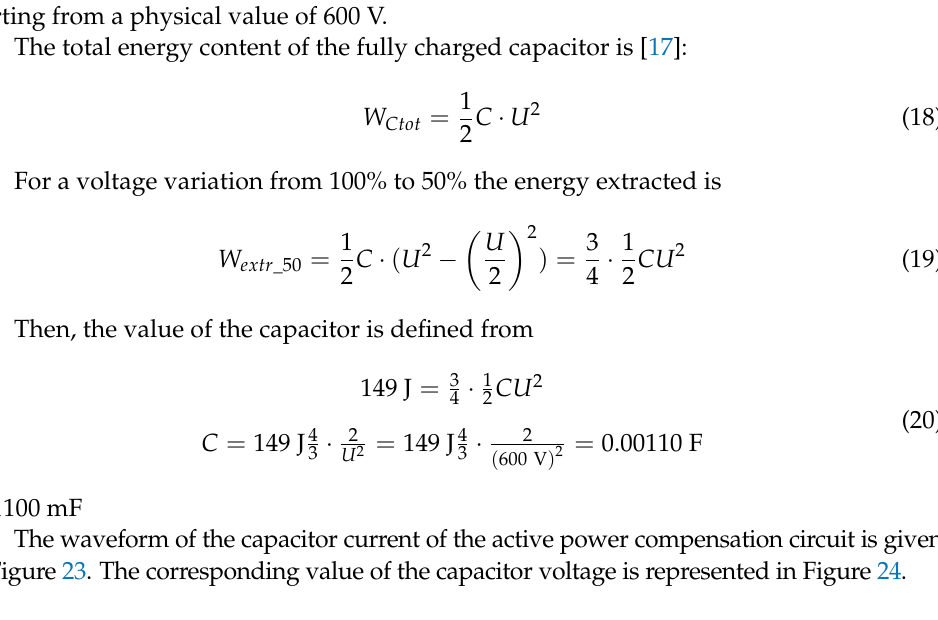
Figure 24. Voltage of the storage capacitor (V). 5. Conclusions A new drive system for a Hydrogen compressor has been studied with the goal to increase the energy efficiency of a conventional gas booster. These boosters are used in low power storage facilities or in refueling stations for Hydrogen powered cars. Such gas boosters are currently driven by pneumatic motors which are well known for their very poor energy efficiency. The new drive system is realized using an electric motor powered by a power electronic frequency converter allowing a variable rotational speed. The transmission of the rotational motion of the motor to the linear motion of the compression pistons can be realized with two different coupling mechanisms. The first presented system uses a conventional crankshaft and two piston rods. The second studied system is based on the use of a so-called Scotch-Yoke, which simplifies the realization and limits the external space and dimensions of the complete compressor. The waveforms of the two systems as their forces, torques and power are simulated for a compressor which realizes a pressure shift from 15 bar to 160 bar. A strongly fluctuating power in the driving motor appears due to the strong variation of the pressure in the compression cylinders. For the compensation of these fluctuations a dedicated smoothing equipment is proposed using an active power compensator inter- faced to the DC link of the frequency converter; this avoids the power fluctuations being reflected in the connected grid. This auxiliary smoothing device is based on energy stor- age in a capacitor in which voltage is periodically varied. On the basis of an existing compressor, the main characteristics of the needed equip- ment as driving motor or active power compensator have been specified.